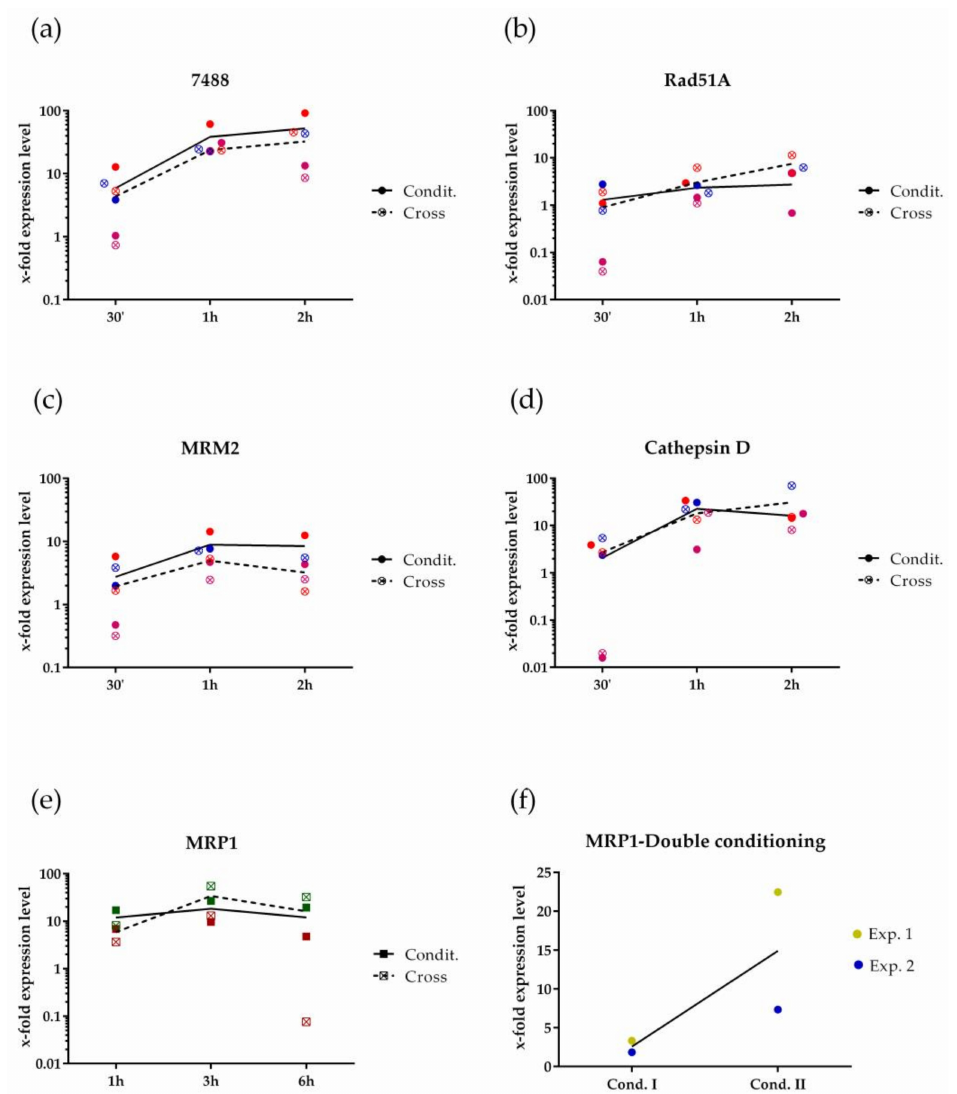
Figure 2. Gene expression analysis in experiments with medium conditioned by the opposite MT. Time course of the expression levels of sexualization markers in P. multistriata cells incubated with the filtered medium of the opposite MT culture and comparison with the expression levels in the corresponding co-cultures where sexual reproduction occurs. ( a – d ) 7488, Rad51A , MRM2 , and Cathepsin D qPCRs performed on different MT − strains “conditioned” (closed circle) or co-cultured (crossed circle) with different MT+ strains; ( e ) MRP1 qPCR performed on different strains of MT+ “conditioned” (closed square) or co-cultured (crossed square) with different MT − strains. Circles and squares represent the fold changes obtained in distinct experiments with different couples of opposite MTs (the same color corresponds to the same experiment); lines represent the median of the different experiments (continuous for the conditioning experiments, dashed for the co-cultures). ( f ) MRP1 qPCR performed on MT+ “single-conditioned” (Cond. I) or “double-conditioned” (Cond. II). Dots represent the expression levels obtained in distinct experiments with different couples of opposite MTs (the same color corresponds to the same experiment); lines represent the median of the different experiments. In each experiment, the expression levels are expressed as x-fold with respect to the corresponding untreated strain, in a logarithmic scale from ( a ) to ( e ), in a linear scale in ( f ).